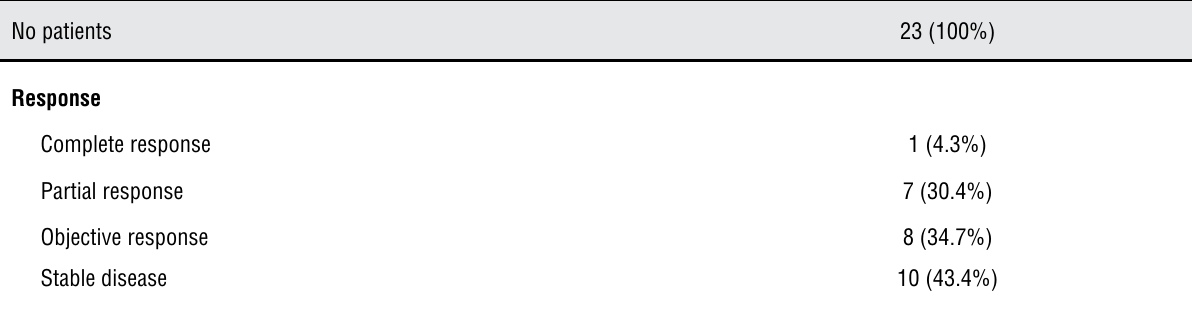
Table 2 – Response